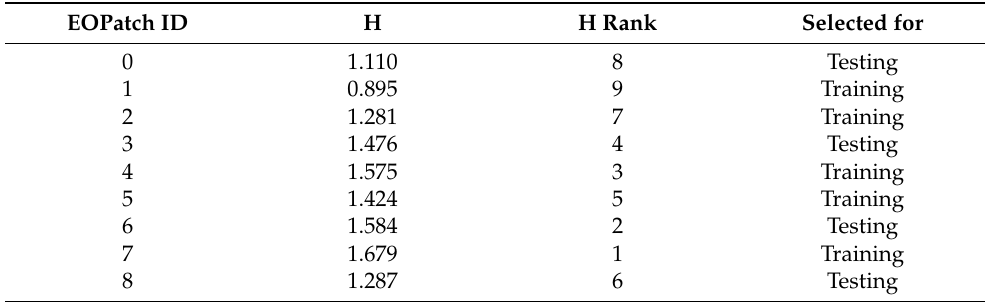
Table 2. Shannon’s entropy as an inter-class balance criterion for each EOPatch used to select training and test sets from the sampled data. Note: H stands for Shannon’s entropy, which is a dimensionless